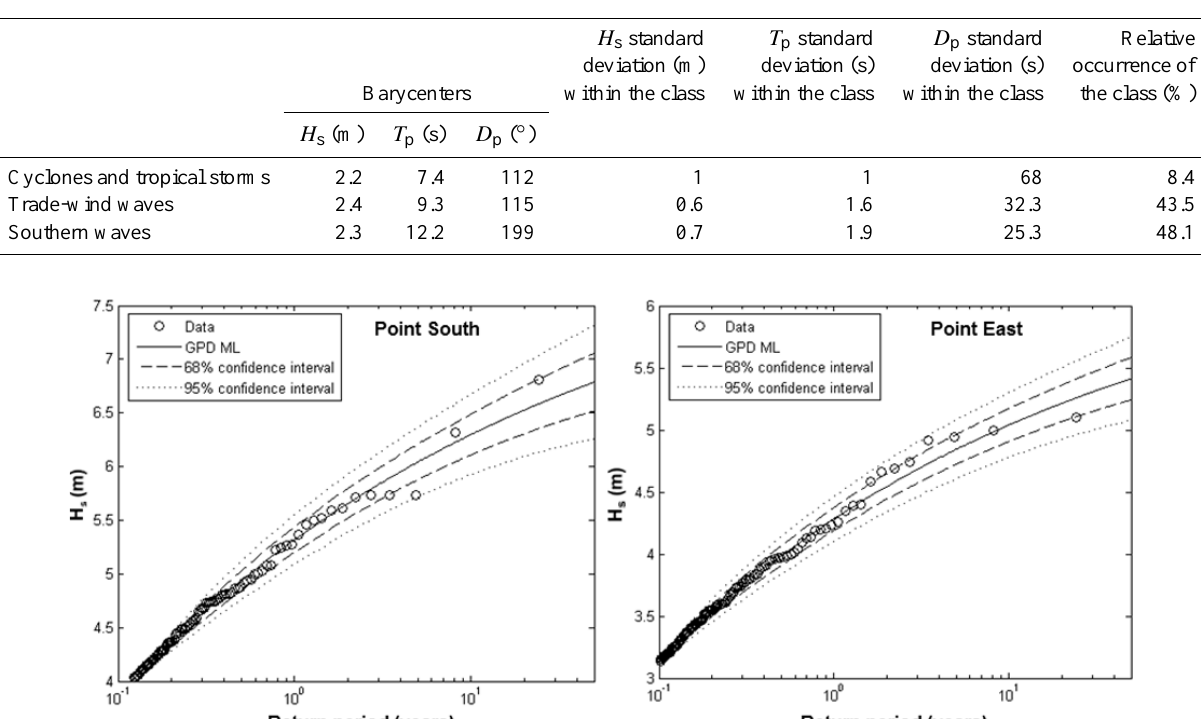
Table 1. GHMM classification of the NWW3 time series at “Point East” (21 ◦ S 56 ◦ 15 0 E). The result obtained for the cyclonic class is a mean of NWW3 model outputs that can be associated to cyclonic waves in the time series. Because of its coarse temporal and spatial resolutions, NWW3 underestimates the cyclonic waves, so that the associated values are not accurate.